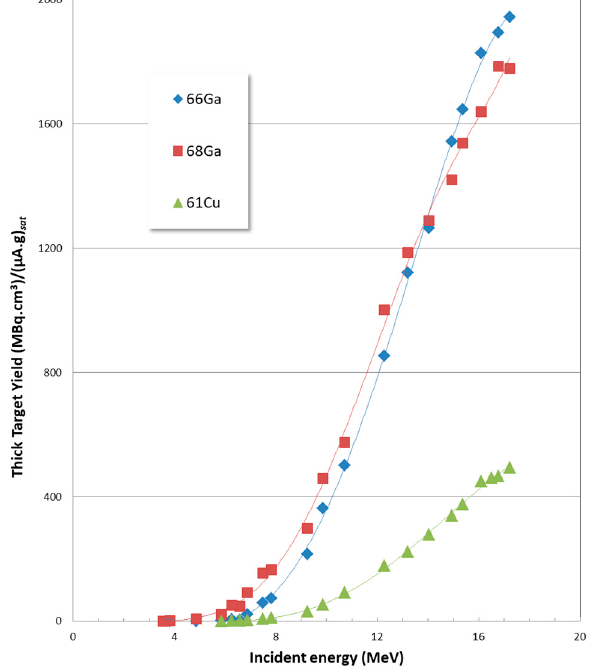
Figure 1. Experimentally measured thick target yields at saturation for the production of 61 Cu, 66 Ga and 68 Ga from the proton irradiation of liquid targets containing dissolved natural zinc.